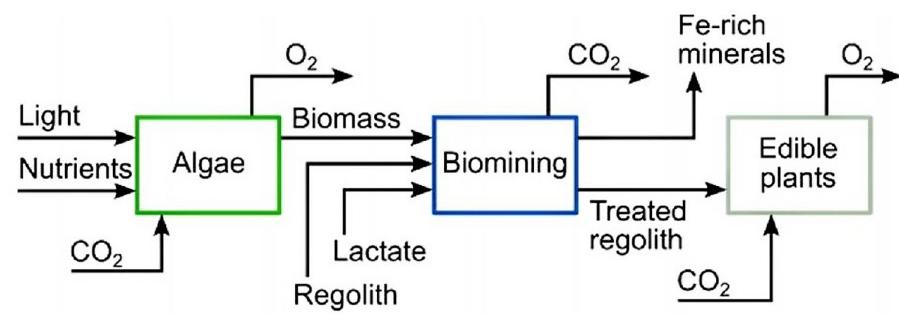
Fig. 16 A shematic represen- tation of bioreactor